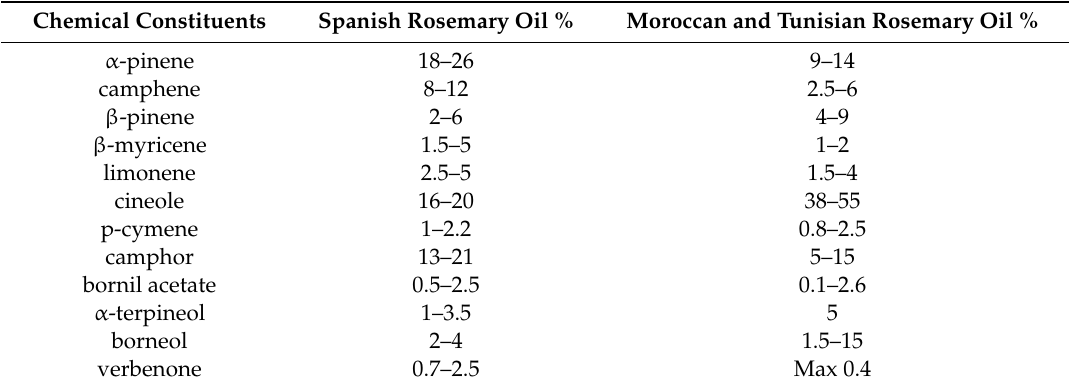
Table 2. Composition of volatile essential oils. Gas chromatographic analysis of Spanish-type and Moroccan- and Tunisian-type rosemary oil (Spanish Royal Pharmacopoeia 2015 = European Pharmacopoeia)